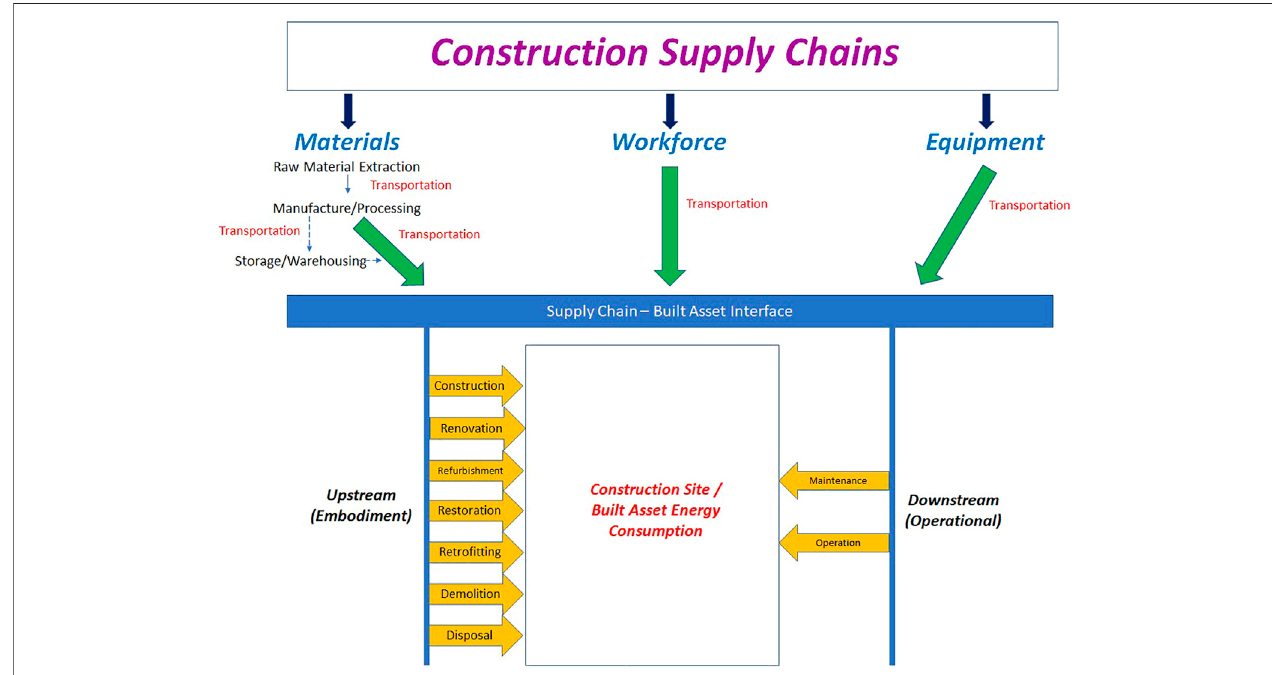
FIGURE1| LifeCycleEnergyAnalysisofabuiltasset(Authors ’ conceptionbasedonCoxandIreland,2002;Rameshetal.,2010;ThomsenandvanderFlier,2011; Chastas et al., 2016).